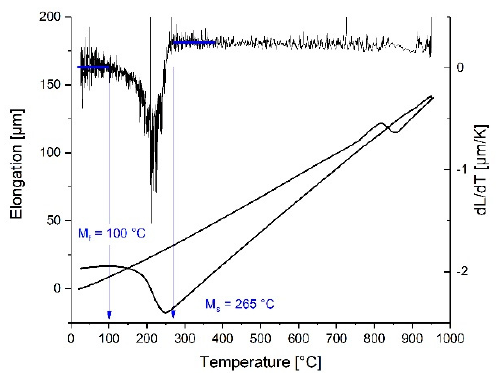
Figure 2. Dilatometric graph for hardening process of 0.54C-1.45Si-0.71Mn, after austenitization at 950 ◦ C for 100 s. Deri-vative curve allows determination of transformation temperatures M s and M f . The characteristic changes in the length of the specimen indicates the martensite start temperature at 265 °C and the martensite finish temperature at 100 °C. Table 2. Overview of processing parameters (quenching temperature QT, partitioning temperature PT and partitioning time Pt) for Q&P treatments.